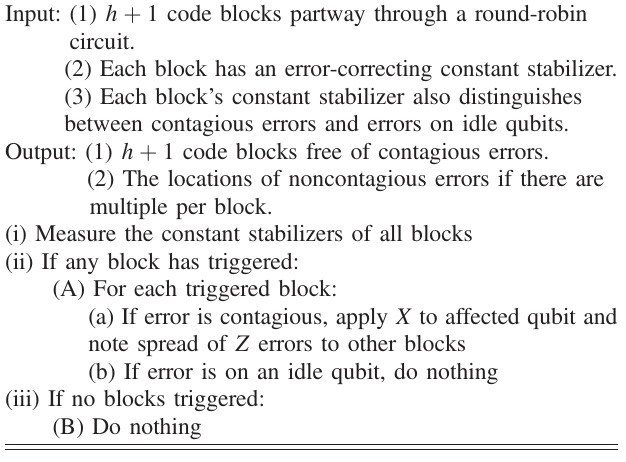
TABLE II. CSS PARSEC. An error-correction procedure achieving the same goals as PARSEC, but without ever having to measure the nonconstant stabilizers of any block. The CSS in the procedure ’ s name stems from the fact that any normalizer of a CSS code that consists entirely of X ’ s and I ’ s or of Z ’ s and I ’ s will have a constant stabilizer satisfying the third input condition (but not necessarily the second, though nondegeneracy of the code is sufficient to do so).